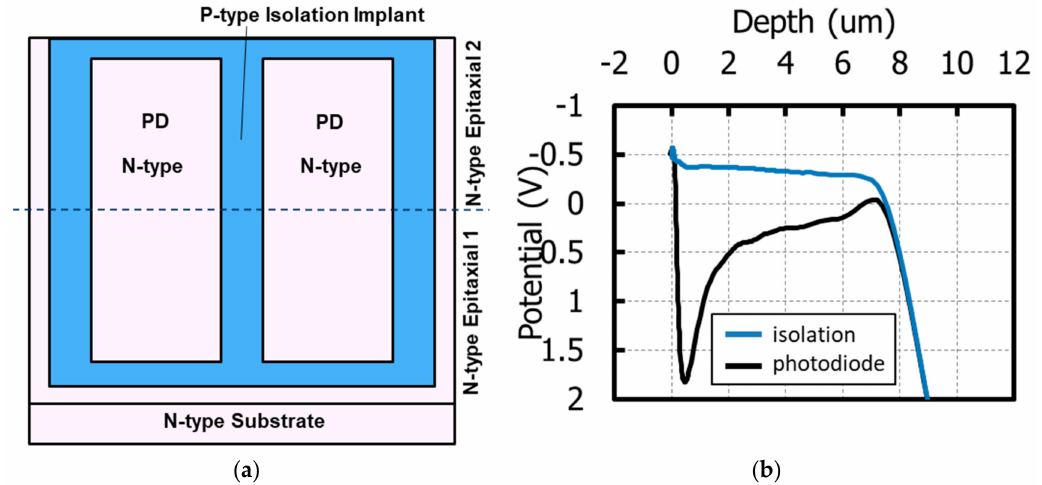
Figure 20. ( a ) Schematic of the cross-sectional structure of a stacked deep photodiode, ( b ) one-dimensional potential of a stacked deep photodiode.